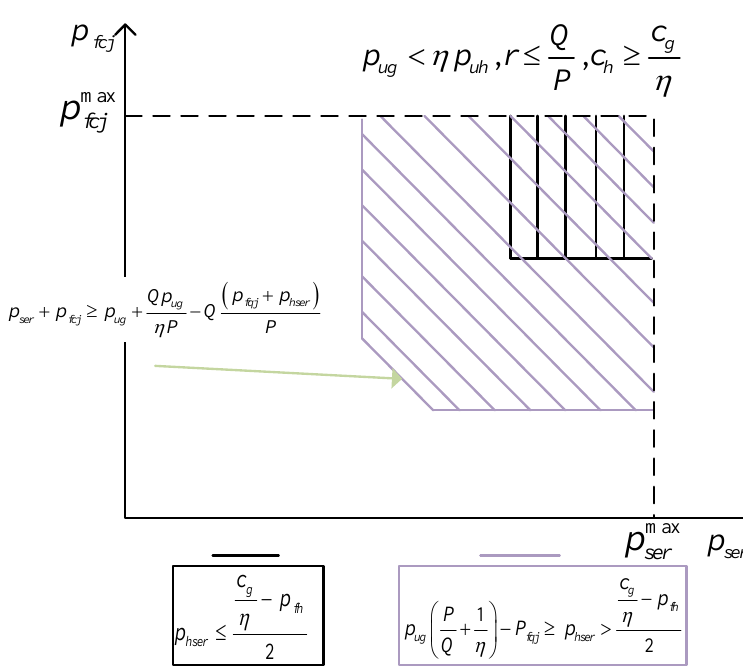
Figure A7. Scenario 7: two-dimensional sketch of the tripartite game Nash equilibria.